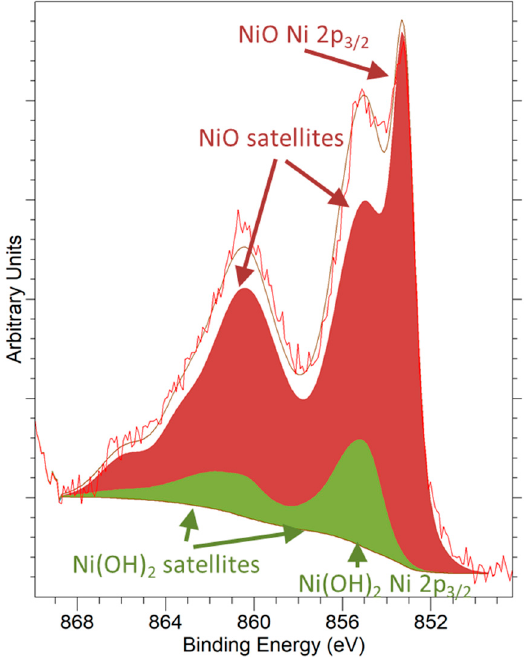
Figure 3. Ni 2 p 3/2 XPS signal registered with an Al K α X-ray source for the as-prepared 5Ni-CeO 2 NCs catalyst. Peak decomposition was accomplished using data from Biesinger et al. [44]. Peaks corresponding to NiO and Ni(OH) 2 appear in dark red and green, respectively (see Supplementary Material for details on the fitting procedure, Figure S2).